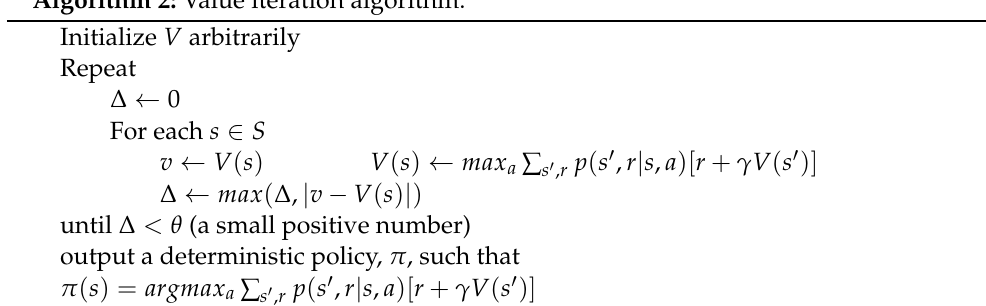
Algorithm 2: Value iteration